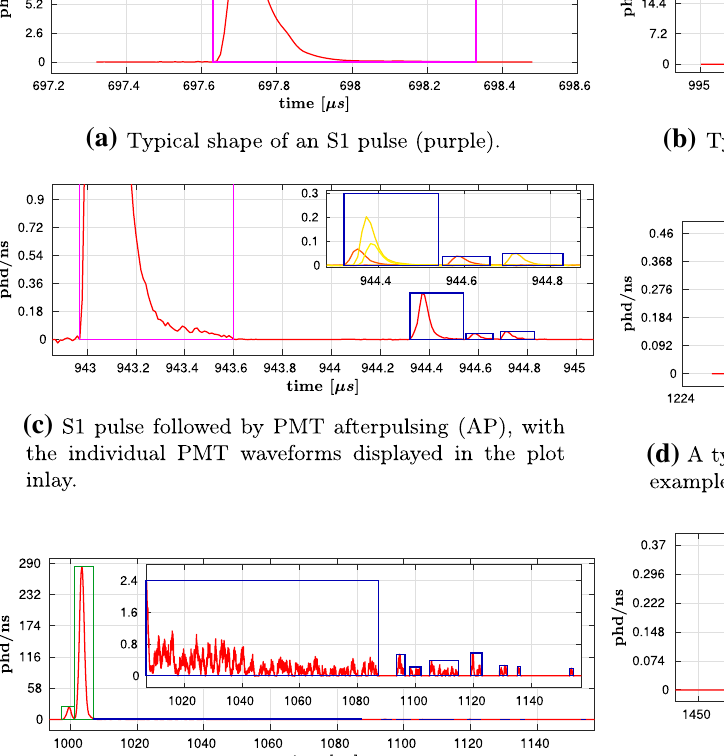
pulses of an event, respectively. The splitting of single electron (SE) pulses, like the example presented in f , is particularly challenging to the classification, since these spurious pulses have characteristics that are very similar to S1 pulses and PMT afterpulsing